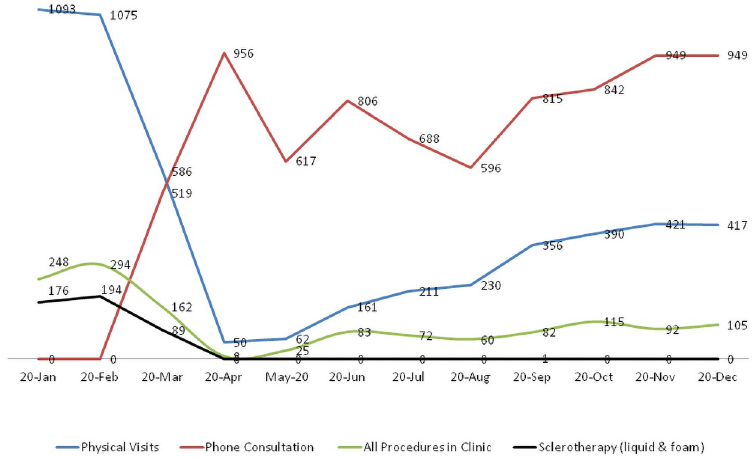
Fig 4. Patient encounters and procedures done at vascular surgery outpatient clinic at Hamad General Hospital during the COVID-19 period.